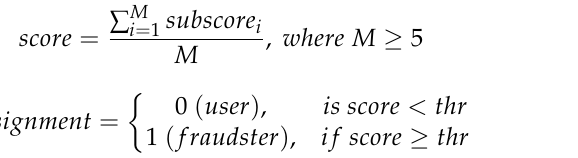
( b ) Figure 6. Average ( a ) and standard deviation ( b ) of gyroscopes’ x and y axes (all users). 2.3. XGBoost Training To train a model, the user’s data (sub-sessions) were labeled as an authorized session and the data considering the remaining 126 users were labeled as a fraudulent one. Subsequently, the data set was passed to the XGBoost classifier—the boosting estimator based on decision trees [25–30], in which the trees are expanded to a forest where each estimator is built on the residual value of the previous classification. To reach the best possible model, the XGBoost’s hyperparameters were tuned for the whole population [31]. The method used for reaching the best possible model quality is presented in a flow chart in Figure 7. The method trains users stored in a queue with certain hyperparameters set. When all the users are trained, their mean model quality is calculated and is treated as fitness. This procedure was reproduced a fixed number of times with a different set of hyperparameters (which came from the evolutionary algorithm). The best hyperparameter set did not change and was treated as the target set.